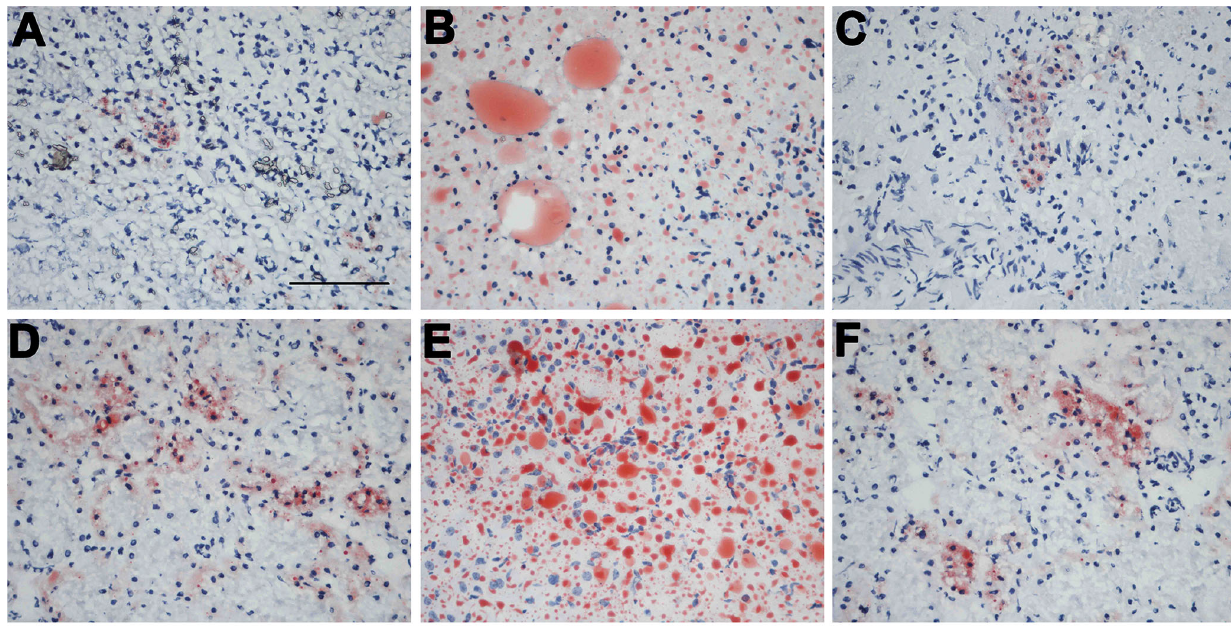
Figure 5. Quercetin and allopurinol reduce renal lipid accumulation in streptozotocin (STZ)-treated rats. Representative micrographs demonstrated kidney histology in different groups of rats. Kidney sections were stained with oil-red O. Normal control (A), STZ alone (B), STZ plus 100 mg/kg quercetin (C), STZ plus 50 mg/kg quercetin (D), STZ plus 25 mg/kg quercetin (E) and STZ plus 10 mg/kg allopurinol (F). Bar=50 m m in Fig.